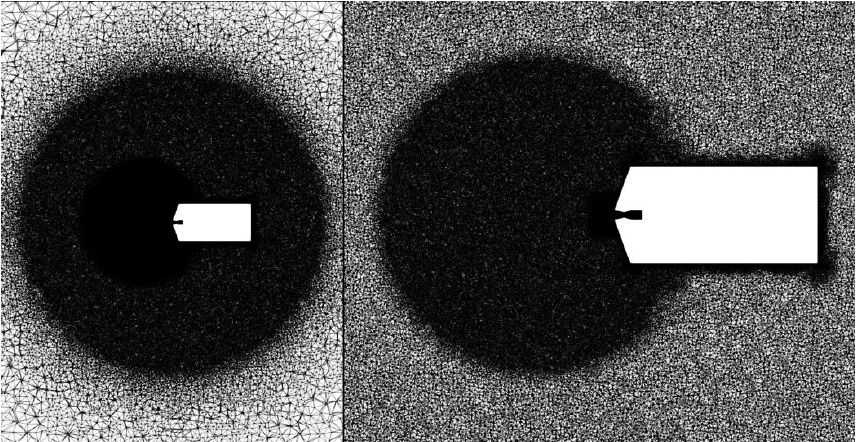
Figure 4. Y-plane centerline slice of 80 million cell SRP unstructured grid.